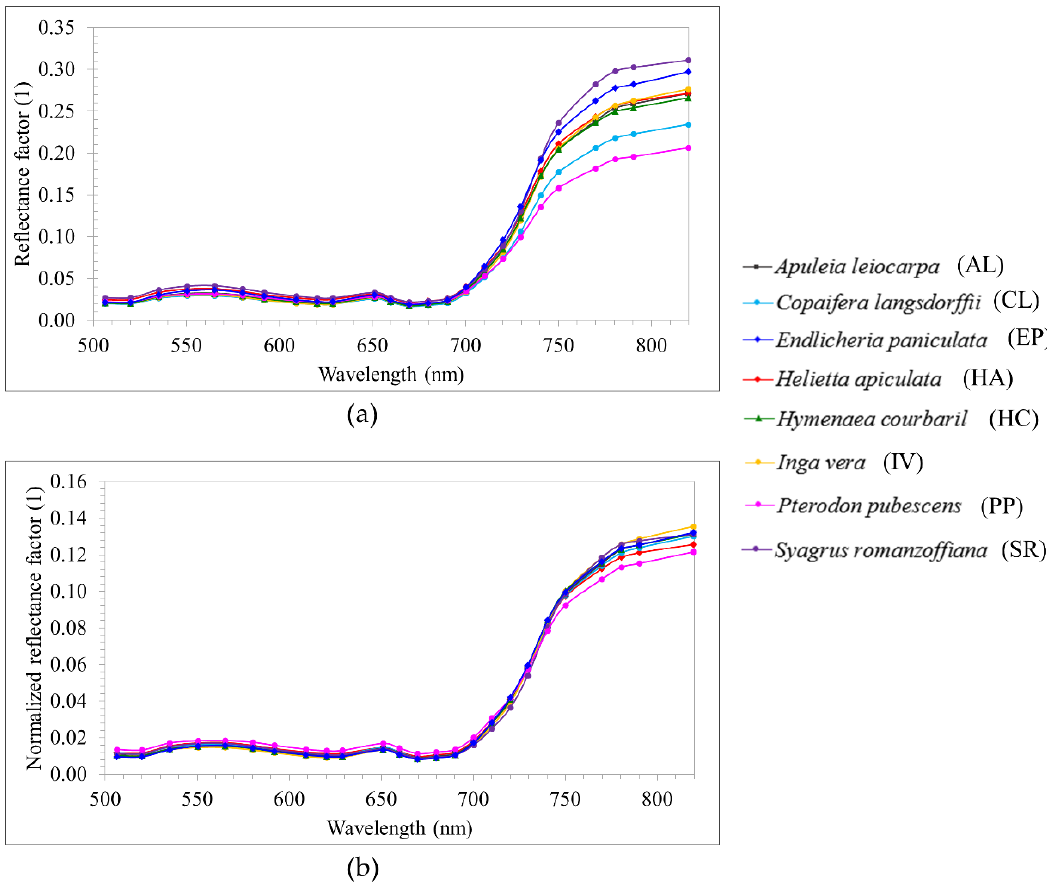
Figure 7. Mean spectra of each tree species considering the: ( a ) Mean, and the ( b ) MeanNorm.